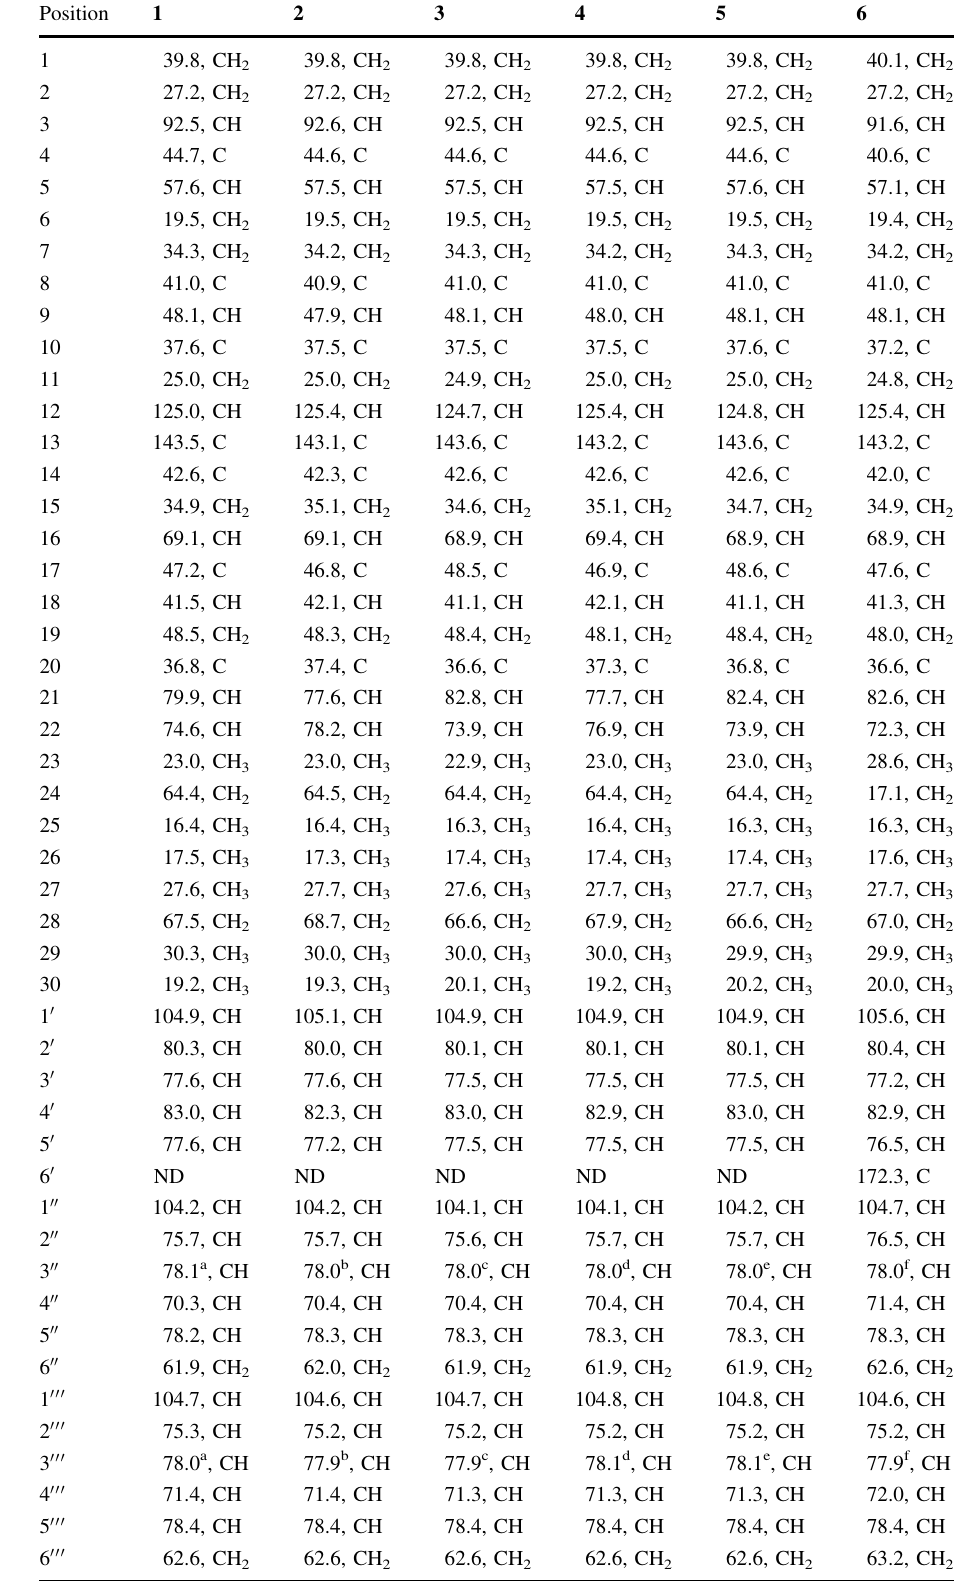
Table 2 13 C-NMR data of compounds 1 – 6 recorded in methanol- d 4 ( d in ppm, 150